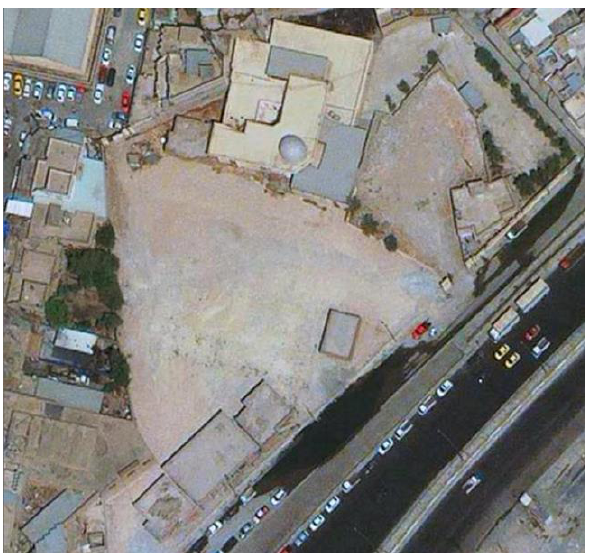
Figure 9. Example of “before” destruction of contiguous buildings in Nineveh